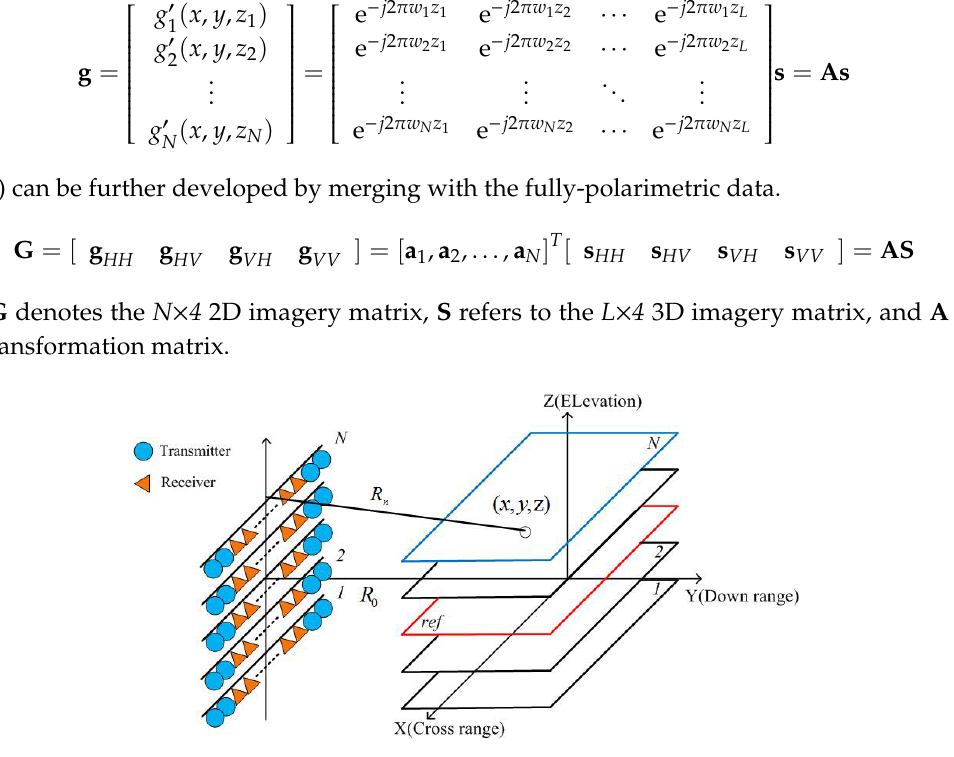
Figure 1. Geometry of multiple-input multiple-output synthetic aperture radar (MIMO-SAR) tomography.